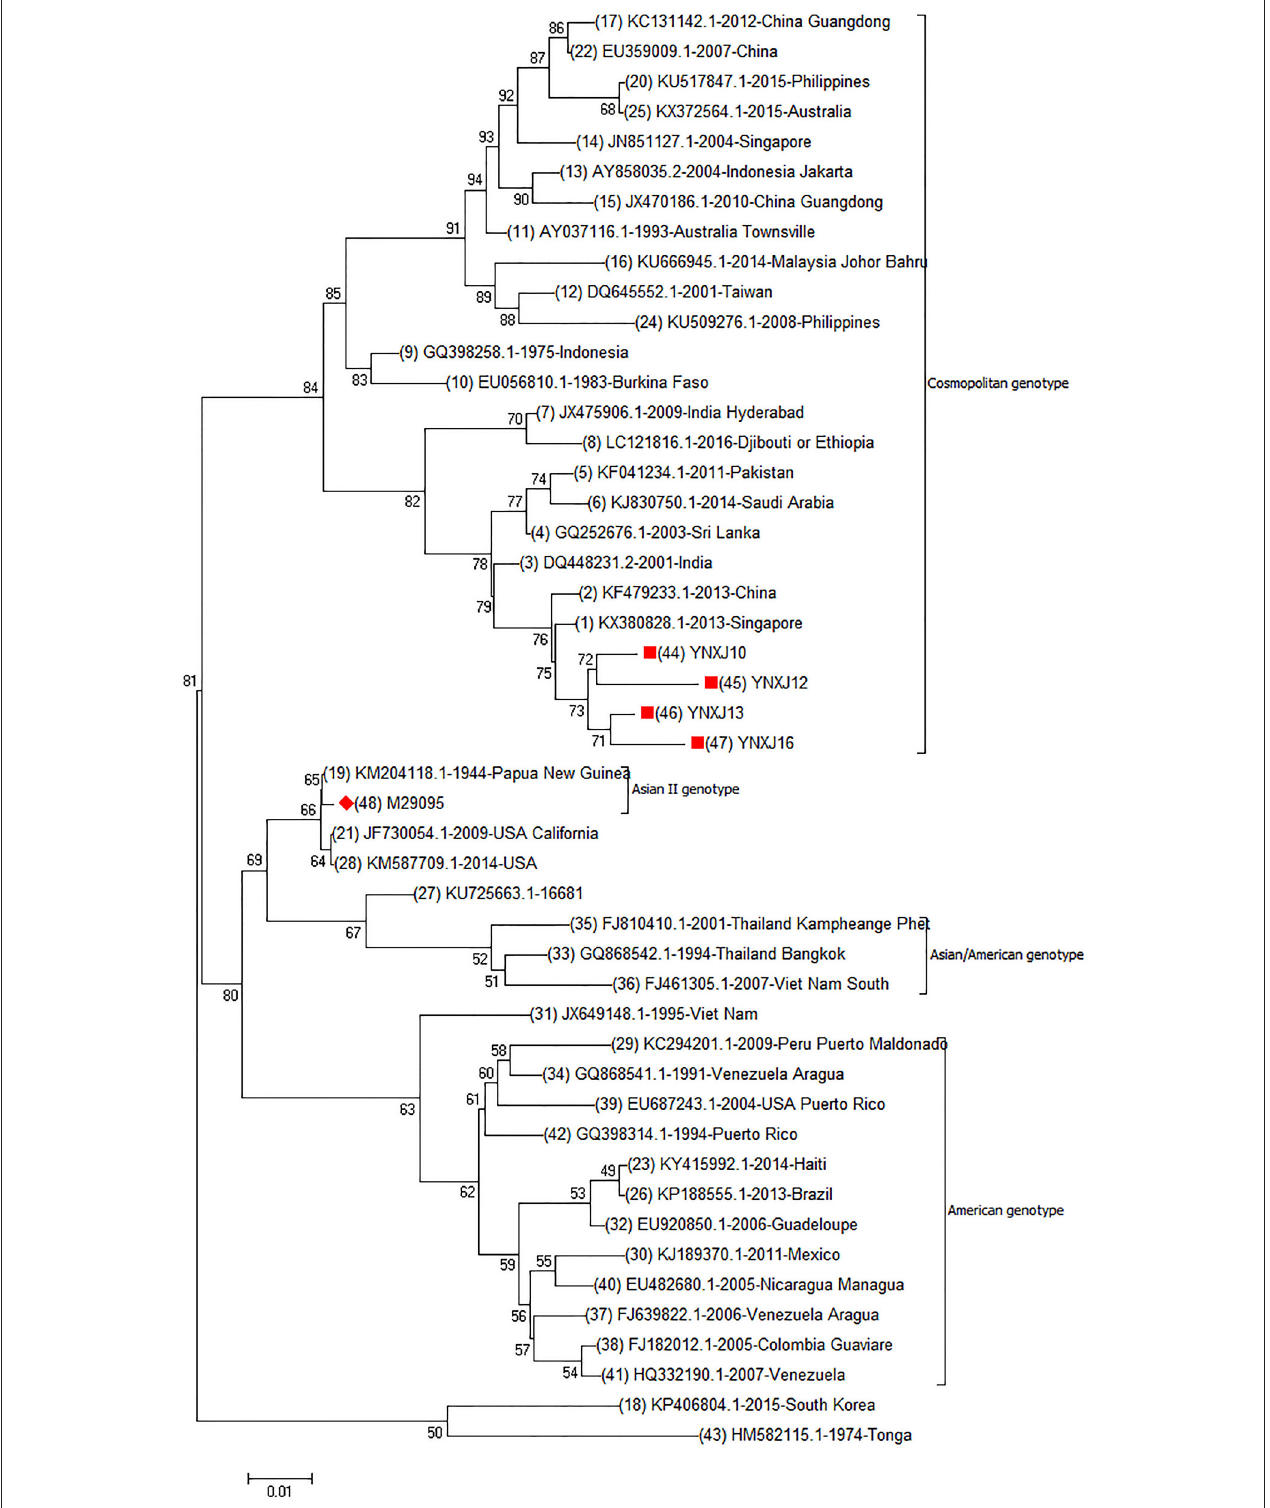
FIGURE 1 | Complete genomic phylogenetic analysis of YNXJ10, YNXJ12, YNXJ13, and YNXJ16. Study sequences are labeled in the red circle. The DENV-2 standard M29095 are labeled with red diamond. Others are representative of DENV-2 from diverse geographical origins retrieved from GenBank. Phylogenetic analysis, based on the complete genomes, was conducted using the MEGA software version 7.0 (maximum likelihood phylogeny test) and gamma-distributed rates among sites with 1,000 bootstrap replicates.